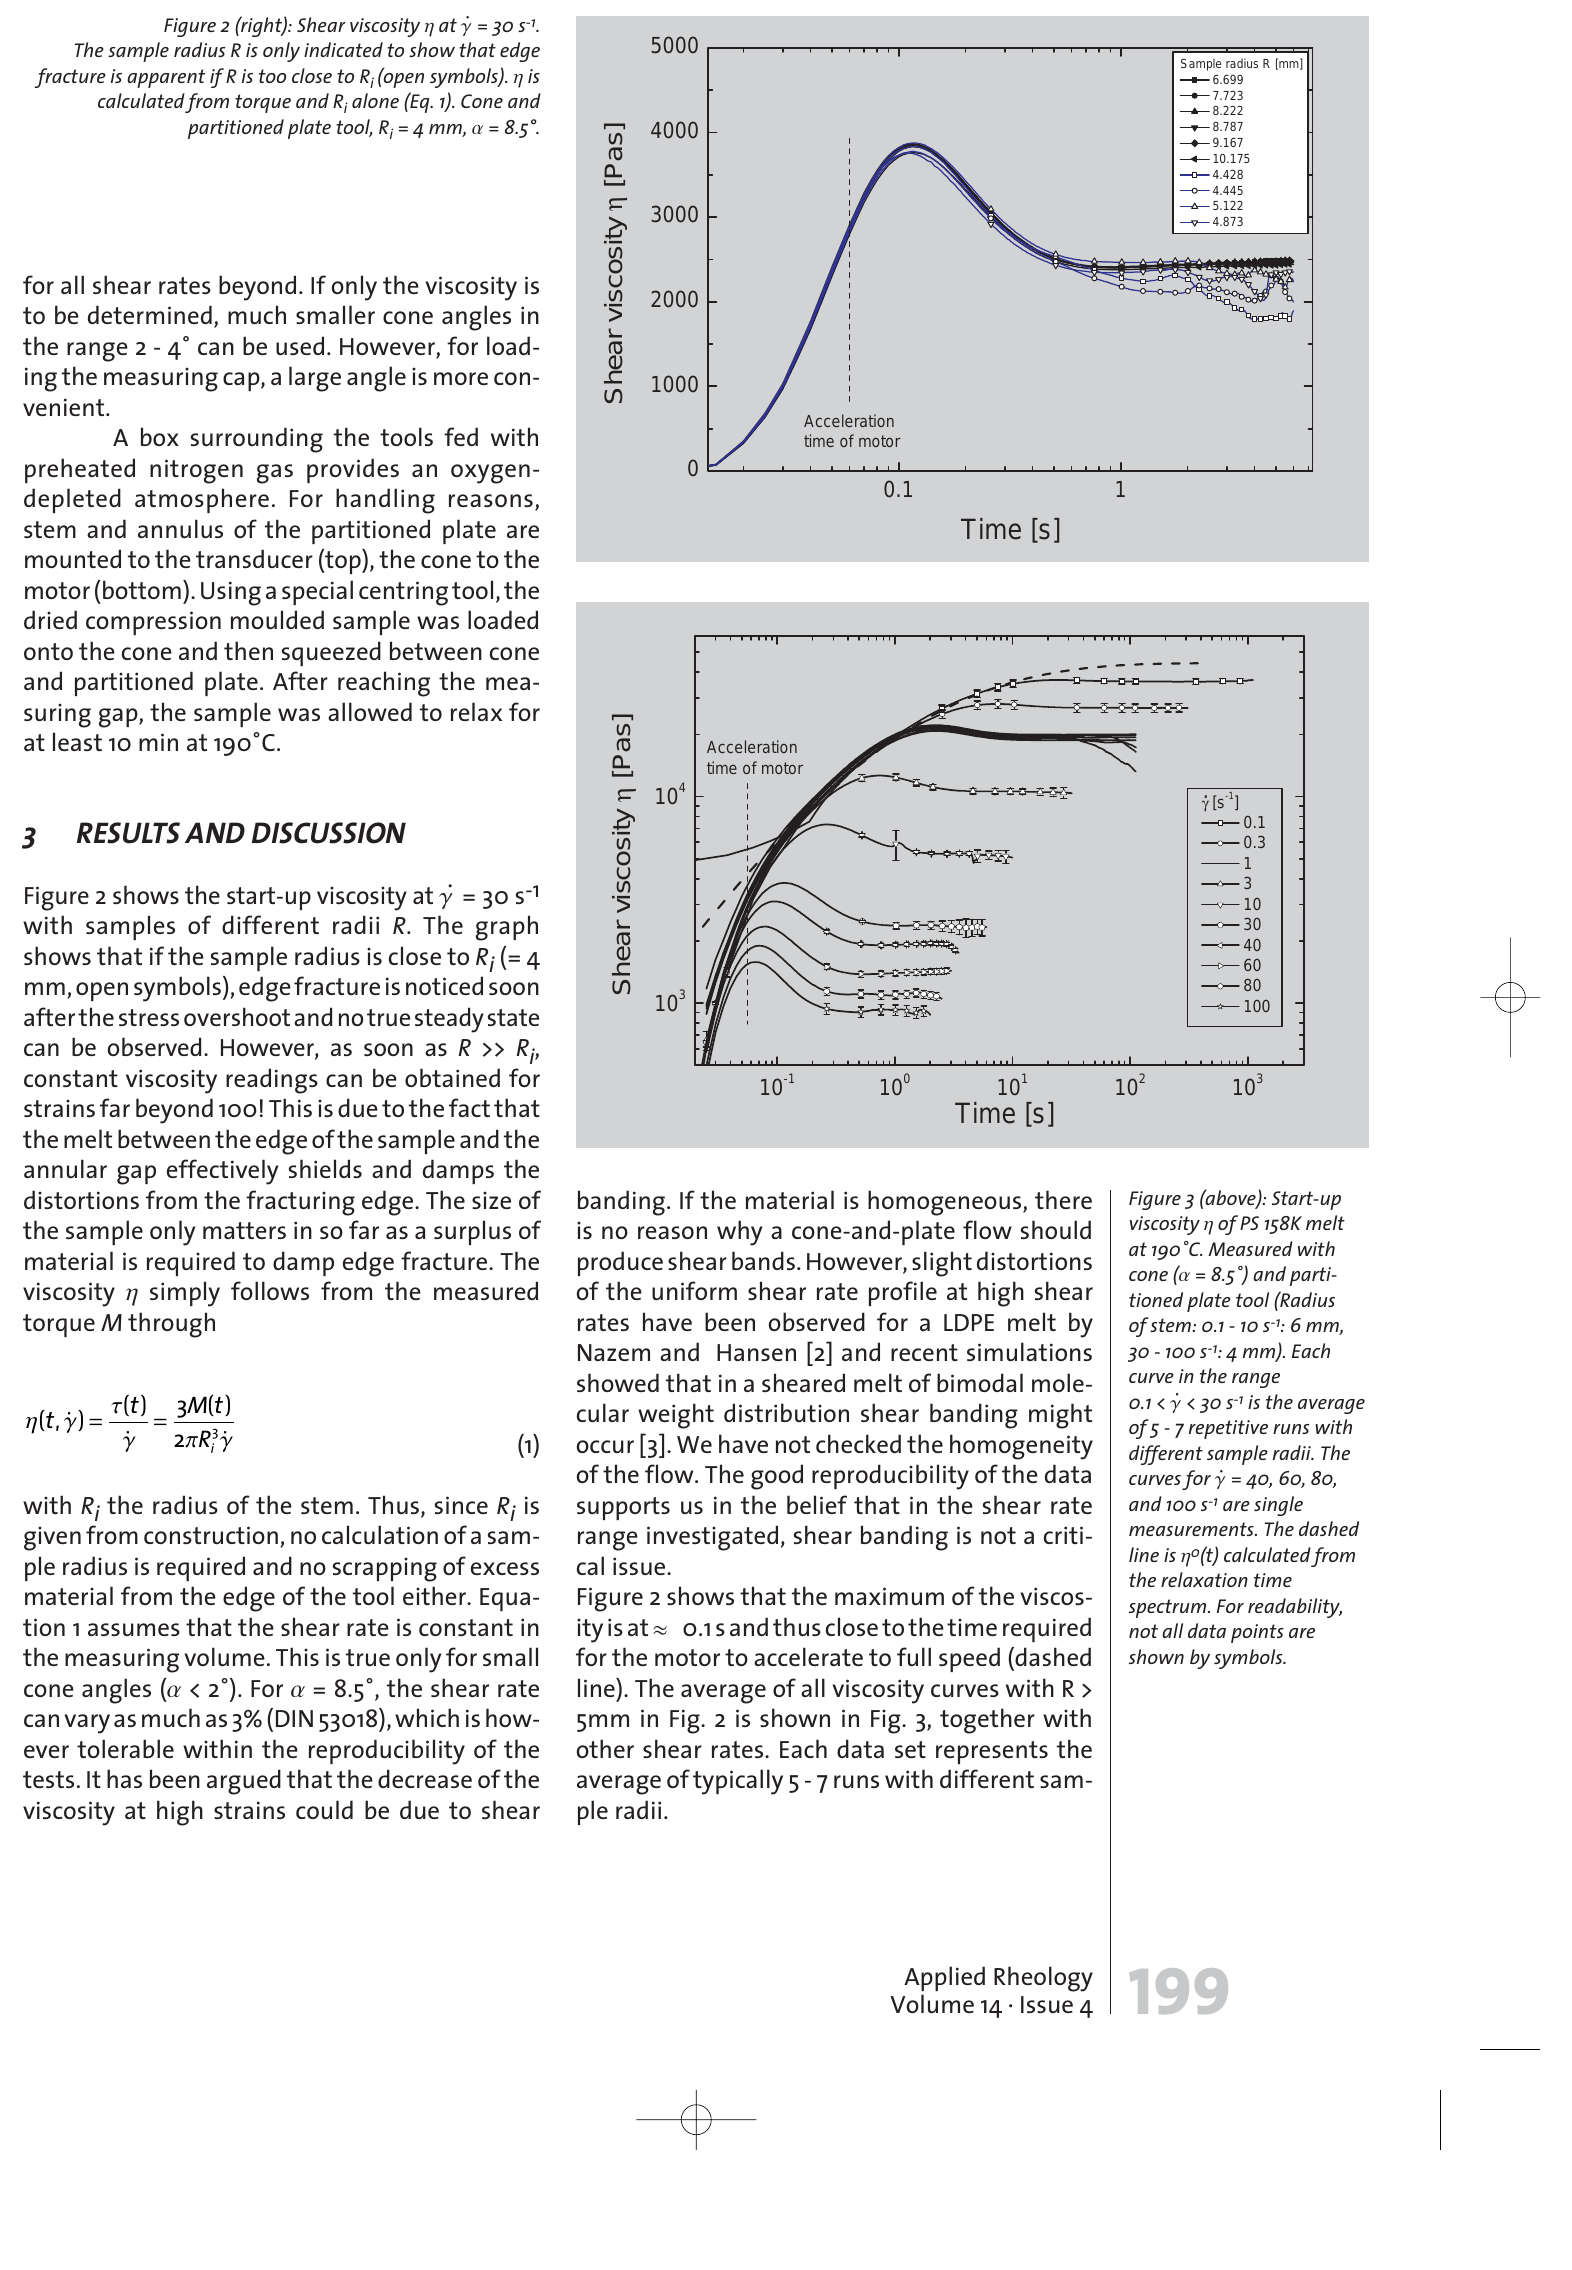
symbols.Figure 2 (right): Shear viscosity h at g · = 30 s -1 . The sample radius R is only indicated to show that edge fracture is apparent if R is too close to R i (open symbols). h is calculated from torque and R i alone (Eq. 1). Cone and partitioned plate tool, R i = 4 mm, a =